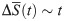
The ΔS¯(t)∼t curve.